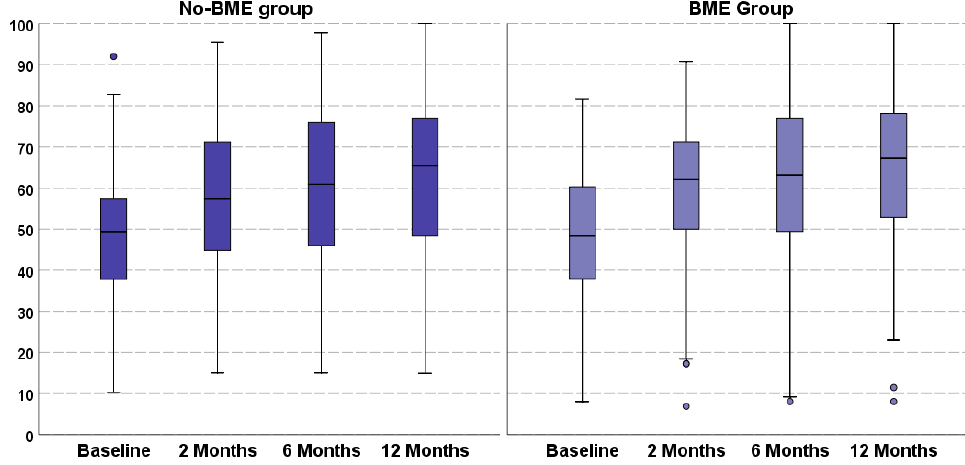
Figure 1. The International Knee Documentation Committee subjective score trend in both no-BME and BME groups. The box-and-whisker plots show median, quartile, and 95% confidence interval. The comparative analysis between the BME group and the no-BME group did not show any significant differences in terms of absolute values and clinical improvement in all scores at all follow-ups (Table 2). Similarly, no statistically significant difference was found between the BME group and the no-BME group in terms of failures: 7 patients (8.8%) in the BME group and 12 patients (9.9%) in the no-BME group required new injective or surgical treatment during the study period.